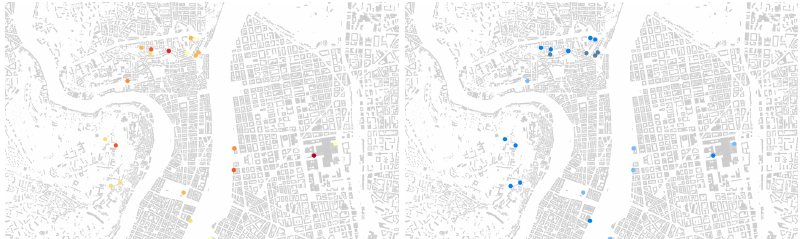
Figure 20. Visualization of vantage points (each point is a vantage point). On the ( left ), the number of landmarks seen from the vantage points (from red, five landmarks seen, to yellow, zero landmarks seen). On the ( right ), effort needed to access the vantage point on foot, in calories (from light blue (less than 20 calories) to dark blue (more than 70